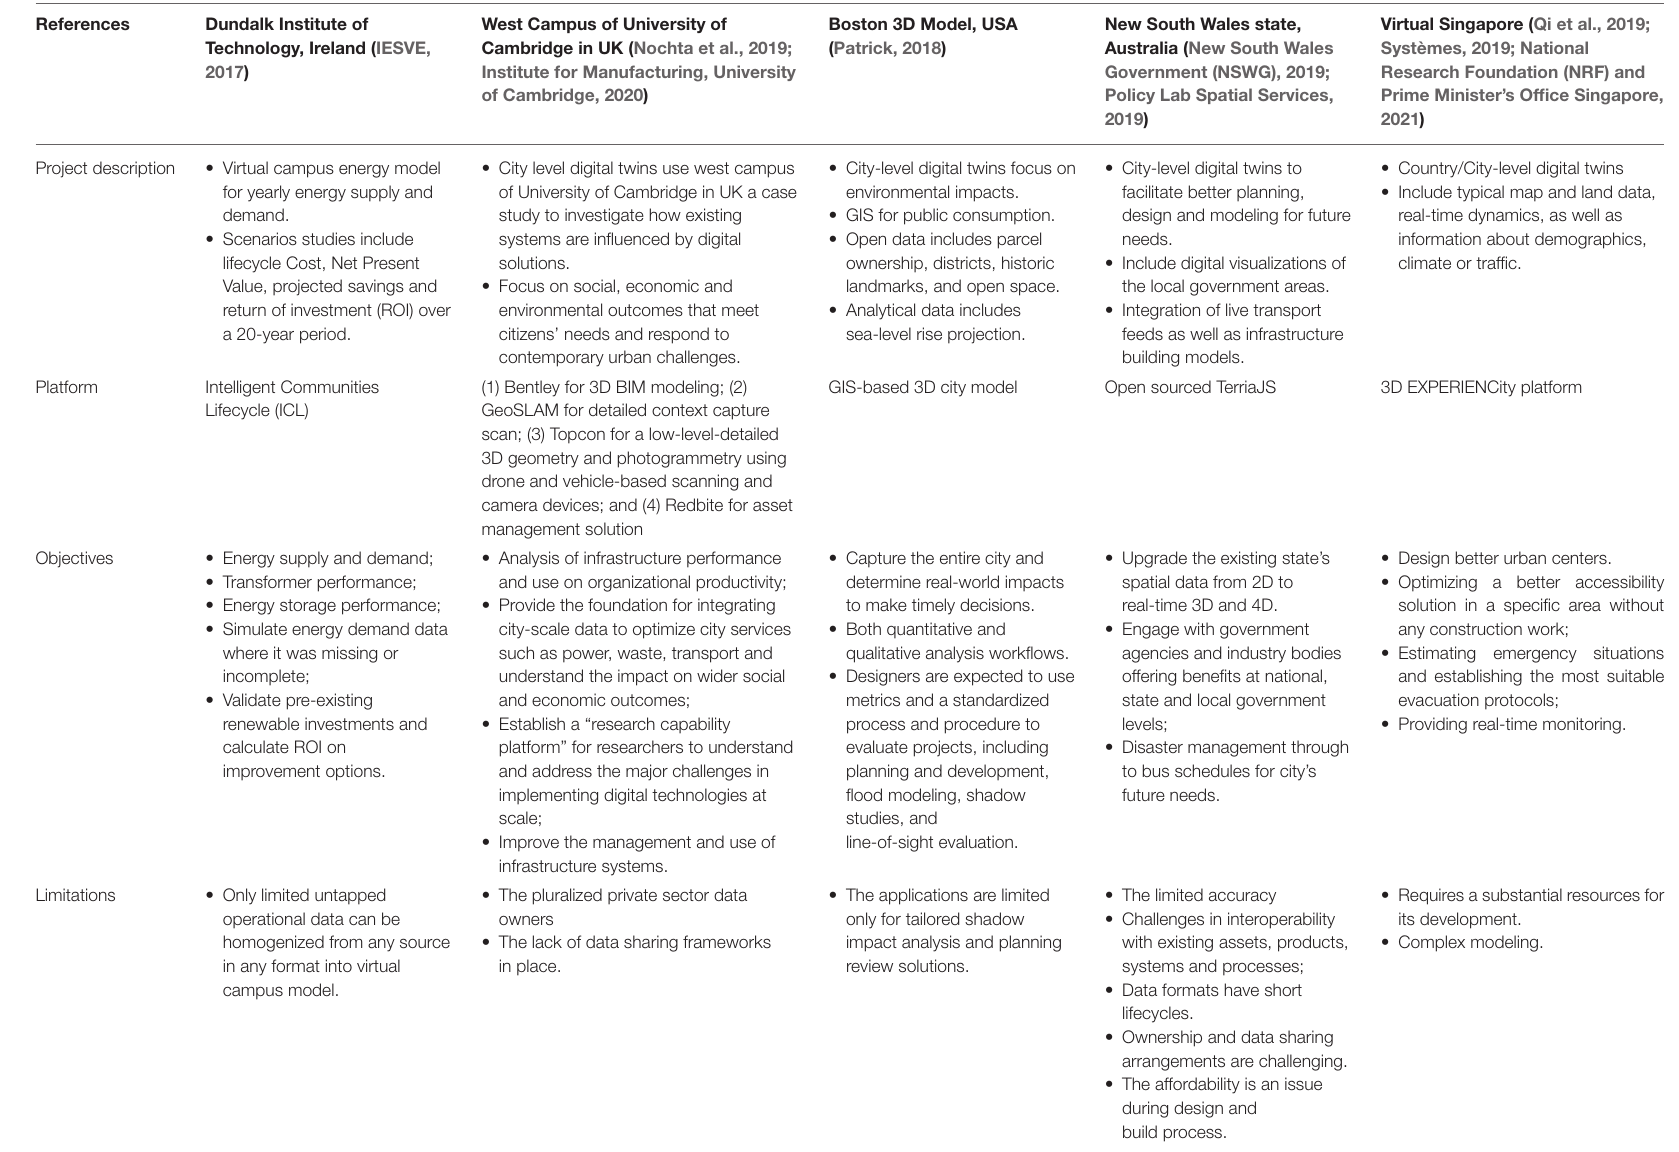
TABLE 1 | Summary of existing application